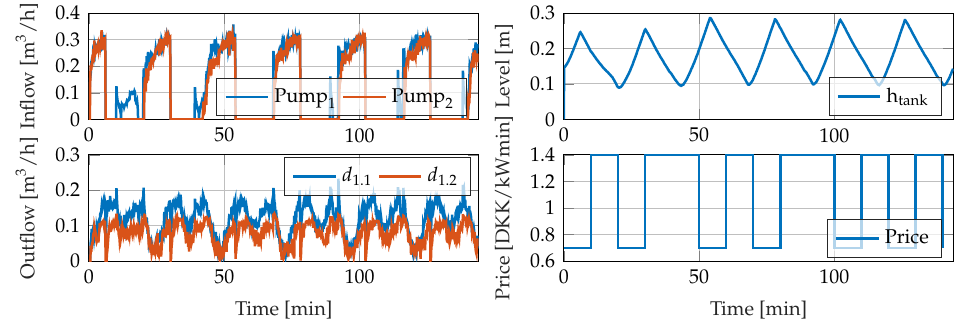
Figure 15. Graphs of the experimental results with non-linear MPC control applied to Bjerringbro’s study case